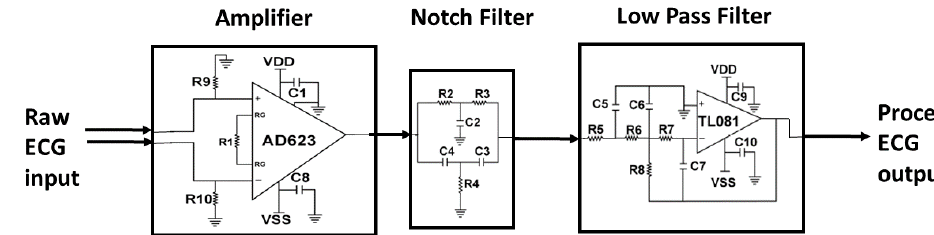
Figure 3. The core PCB circuit diagram.